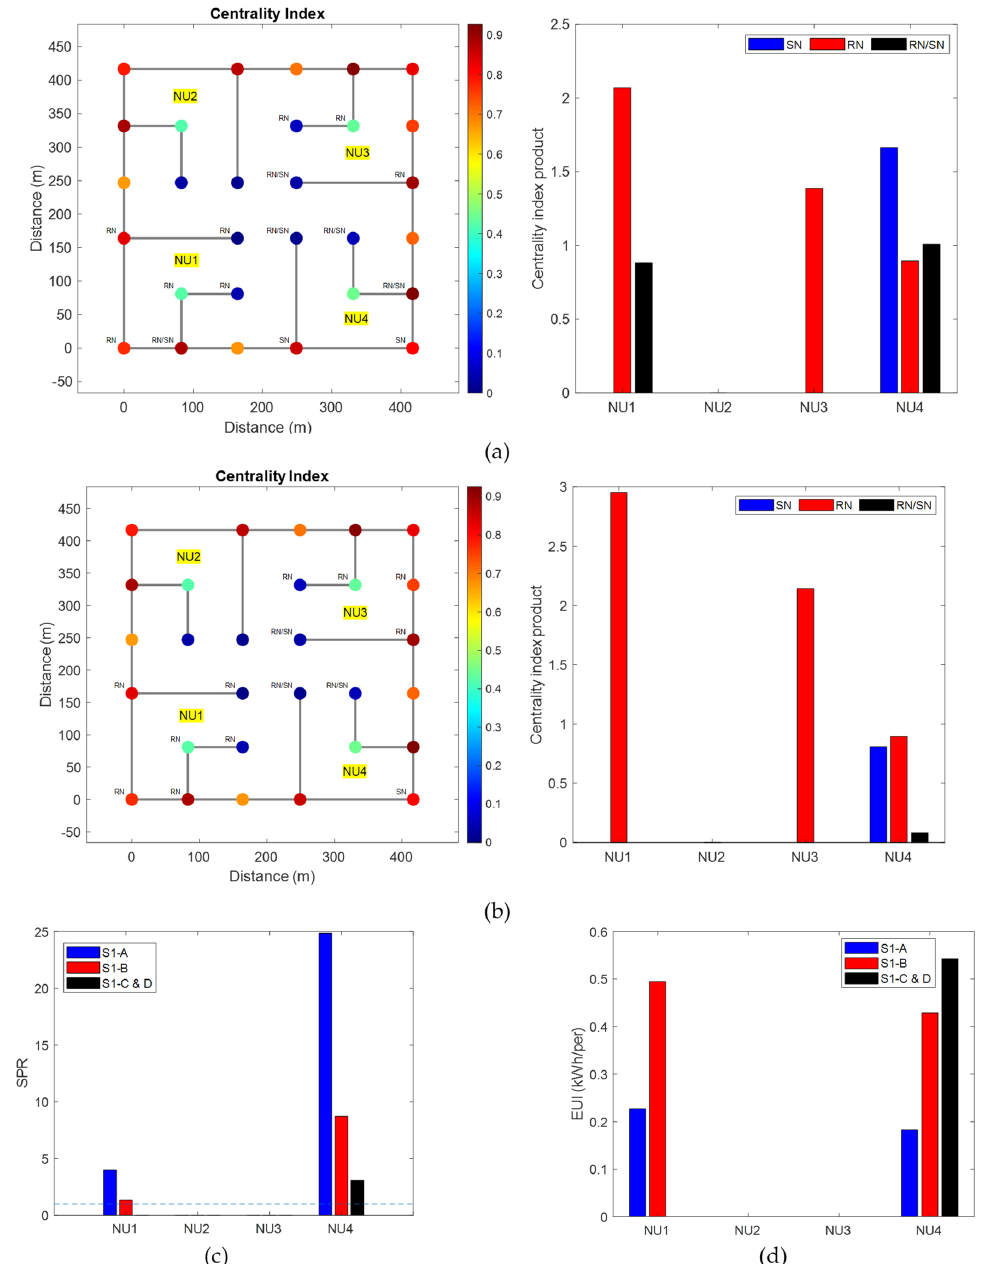
Figure 4. Centrality analysis of combination C3 ( a ) for scenarios S1 − A and S1 − B, ( b ) for scenarios S1 − C and S1 − D along with ( c ) shelter to population ratio (SPR) and ( d ) energy use index (EUI).